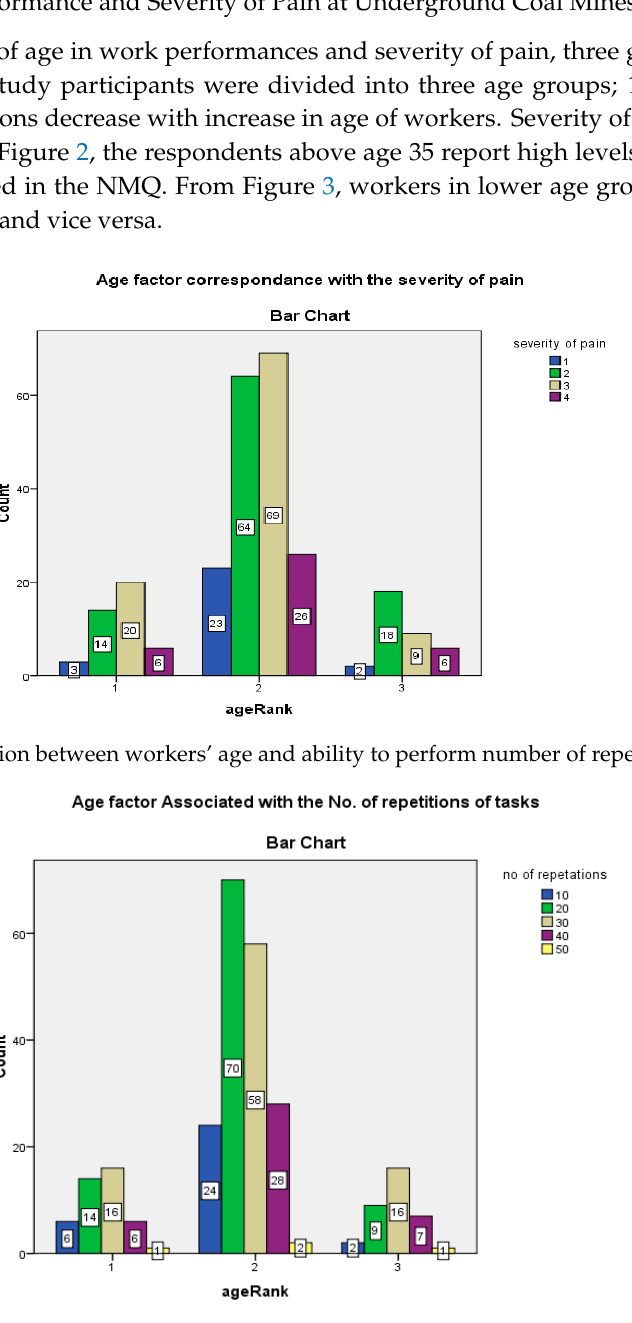
Figure 3. Age of workers inflicting different levels of pain.